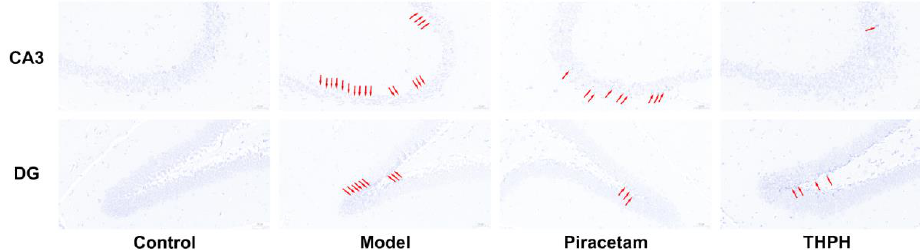
Figure 3. Effect of THPH on morphological changes of neurons in CA3 and DG regions of hippocampus in scopolamine-induced amnesia mice. Histological changes were examined by Nissl staining. The arrows indicate the damaged neurons. Scale bar is 50 μm.